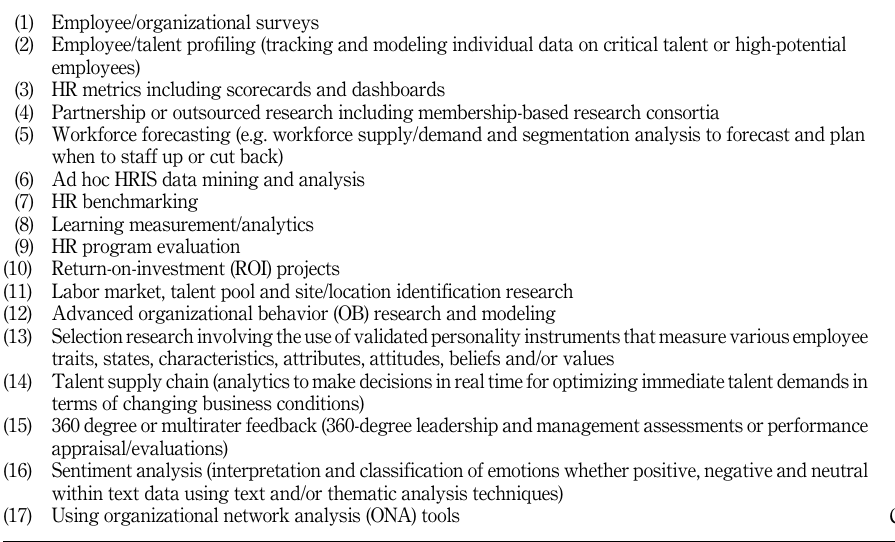
Table 3. Common data